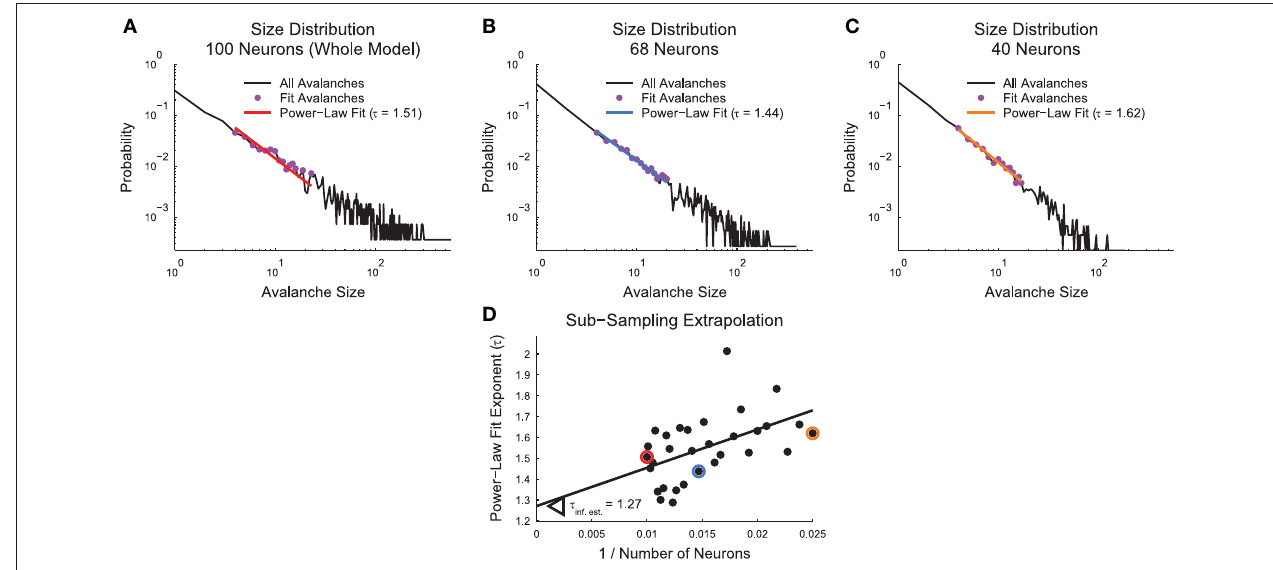
FIGURE 4 | Sub-sampling algorithm. (A–C) Power-law fits for avalanche size distributions for a full example cortical branching model (A) , a sub-sampled version of the same model with 68 neurons (B) , and a sub-sampled version of the same model with 40 neurons (C) . (D) Scatter plot of power-law fit exponents vs. inverse sub-sample size. A weighted linear least squares fit produces an extrapolation of the value for infinite system size at the y-intercept. Highlighted data points correspond to fits from (A–C) via color coding.